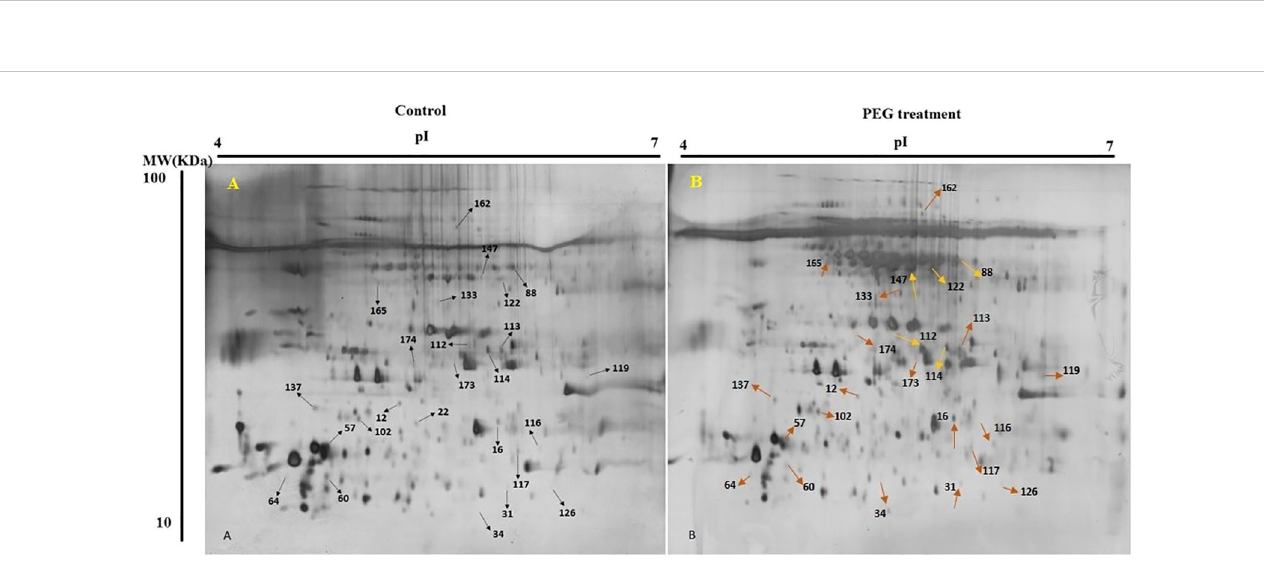
FIGURE 2 2-DE gel images of protein pro fi les from pistachio leaves. Control (A) and PEG treatment (B) . 17cm IPG strip (pH 7-14) was used for loading proteins and SDS-PAGE was done with a 12% gel. Gel was stained using CBB G-250. Proteins with differential regulation levels are marked by